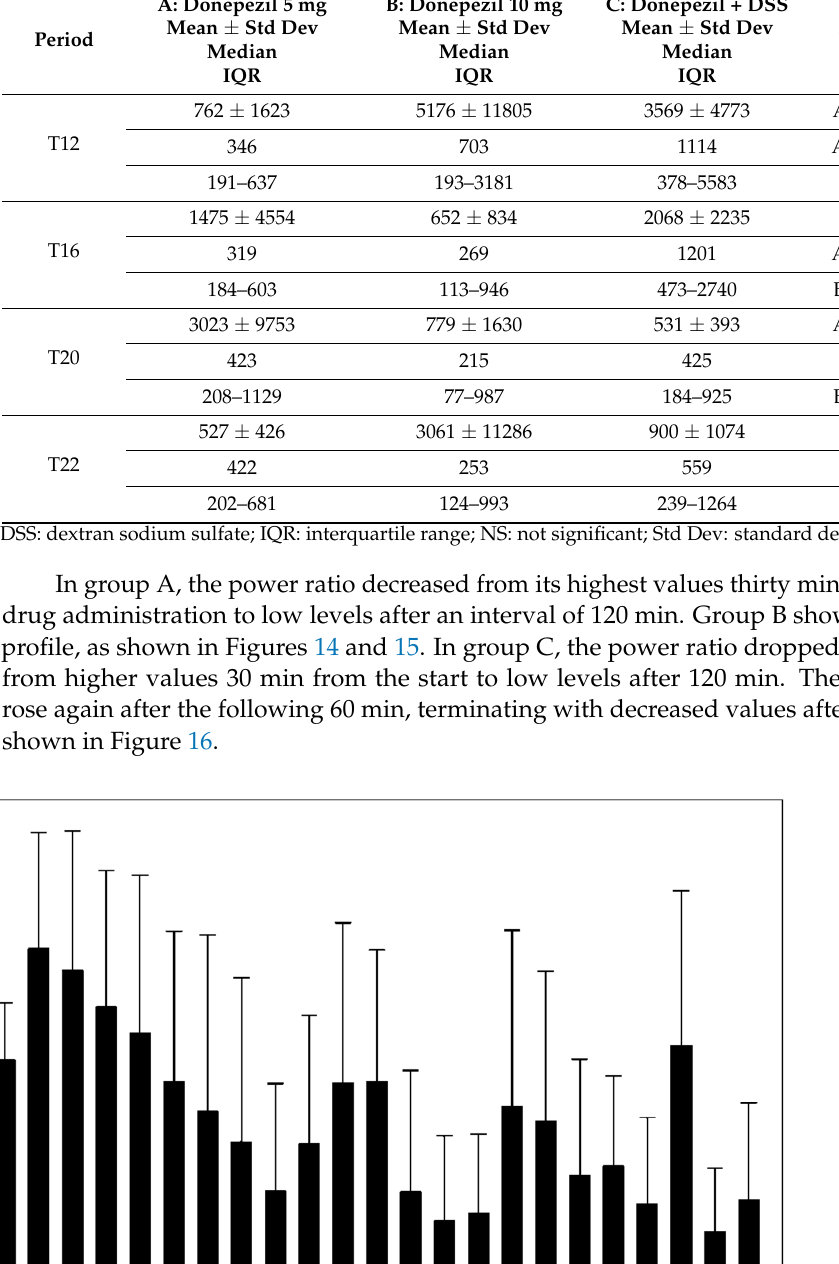
Figure 11. Electrogastrography power after a single intragastric dose of 5 mg of donepezil (group A). Outliers omitted. Y axis: natural log scale.